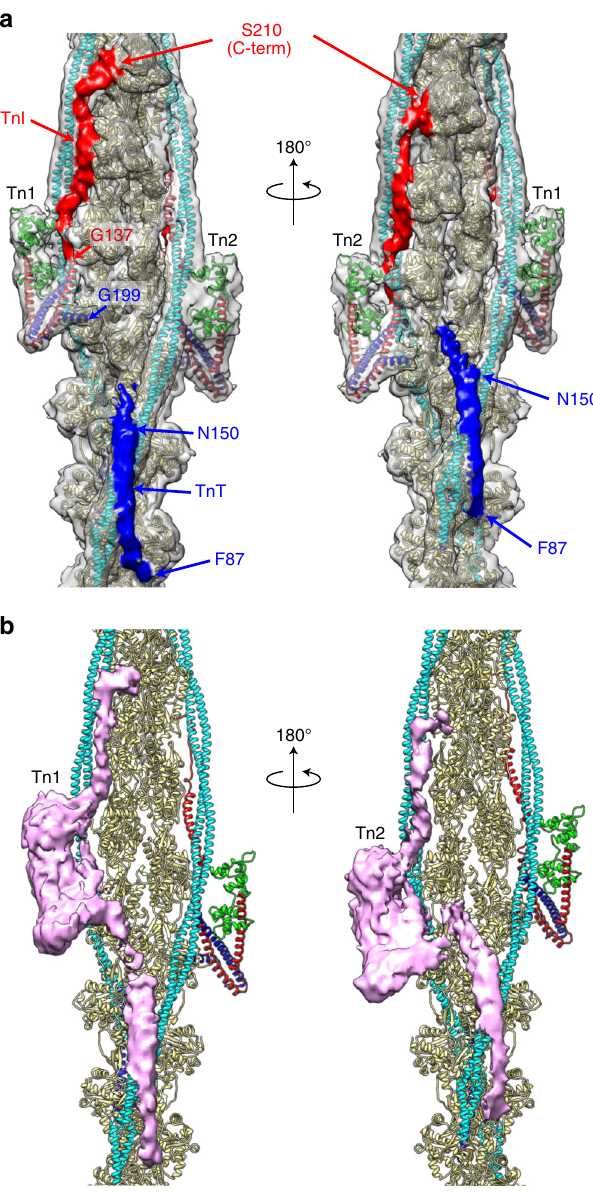
Fig. 2 The entire structures of the Tn complex with two different conformations. a The entire structure of the Tn ternary complex is shown for each of the Tn pair, labeled Tn1 and Tn2, in front and back of the thin fi lament. The difference maps for TnI C and TnT N are colored red and dark blue above and below the Tn core, respectively. The difference in the relative positions of the Tn core and TnT N between the pair is clear while the conformations of the TnI C chains are the same. b The difference map for the entire Tn ternary complex is contoured at a lower level to show the continuous volume of Tn in pink, for each of the Tn pair, again in front and back of the thin fi density (red) extending up along and between actin strand and Tm coiled coil from the C-terminal end (Gly 137) of the TnI helix within the Tn core. This density, identi fi ed as the C-terminal one third of TnI (TnI C ), reaches up to the second actin subunit above the one that binds to TnC N . The other one (dark blue) is also highly elongated and is extending back from Gly 199 of TnT across the actin fi lament strands and down towards Tm on the other actin strand to form a long N-terminal α -helix making a speci fi c interaction with the C-terminal end of Tm near the head-